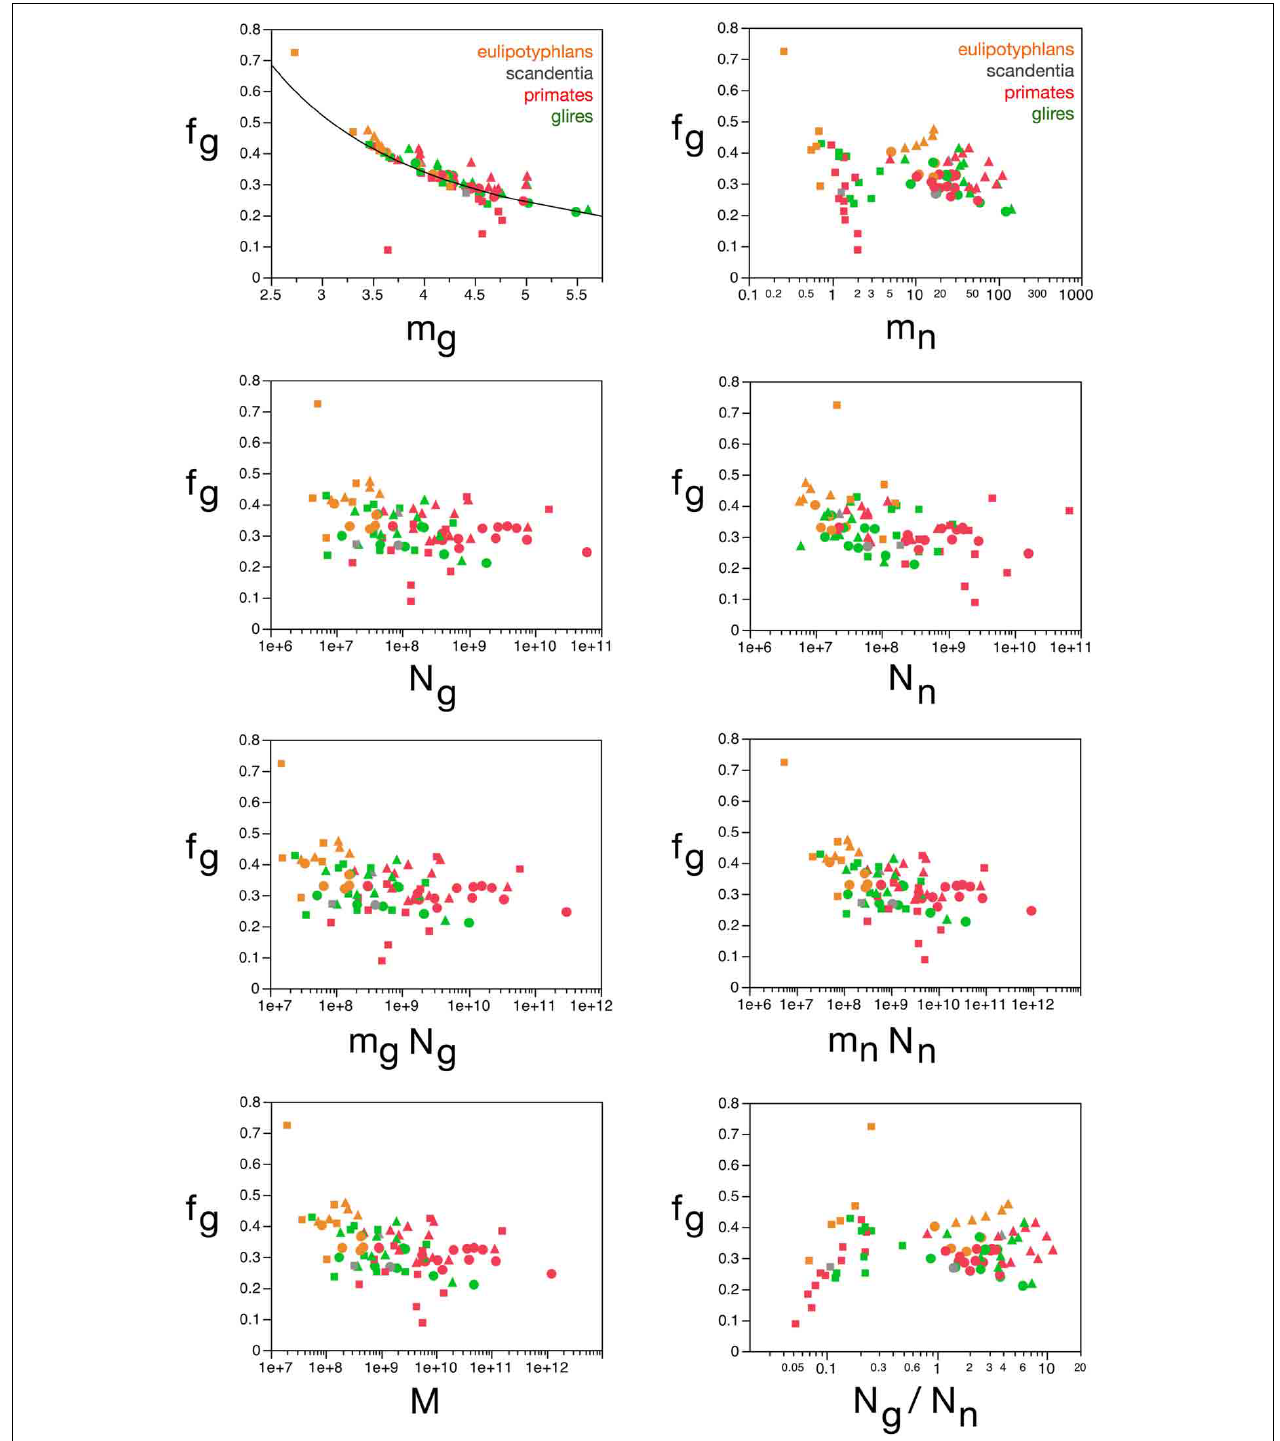
(M),andglia/neuronratiointhestructure( N g /N n ).Noticethatneuronal(orglial) mass fraction is only well predicted by variations in estimated average glial cell mass. All masses in picograms. Cerebral cortex plotted as circles, cerebellum as squares, and rest of brain as triangles; eulipotyphlans shown in orange, primates in red, and rodents in green. Data fromHerculano-Houzel et al.(2006, 2007, 2011), Azevedo et al. (2009), Sarko et al. (2009), and Gabi et al.